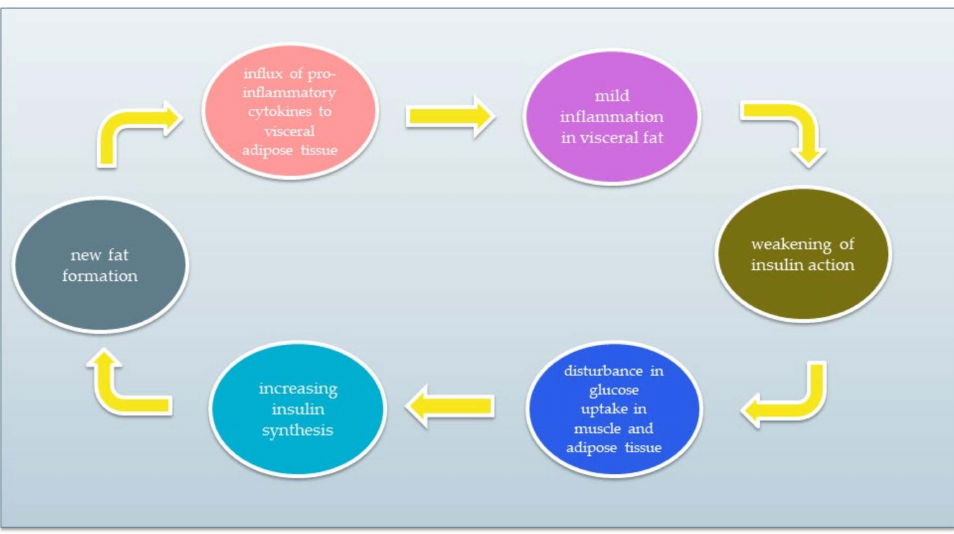
Figure 2. The vicious circle of insulin resistance.